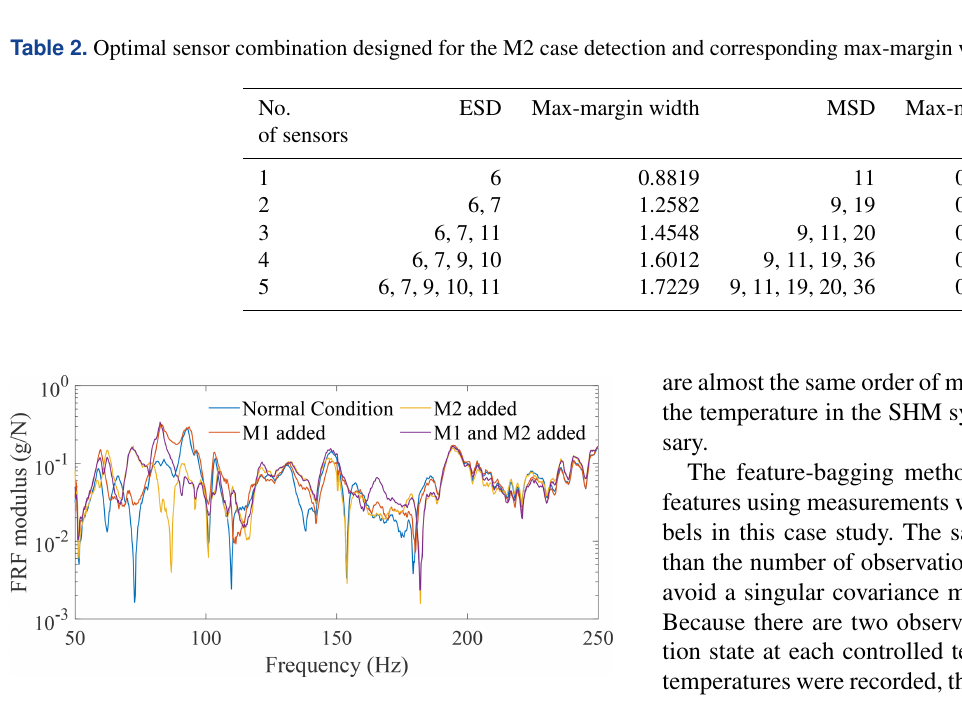
Figure 5. An example of the adopted frequency range: FRFs be- tween 50 Hz and 250Hz collected at 15 ◦ C from sensor 17 for four condition